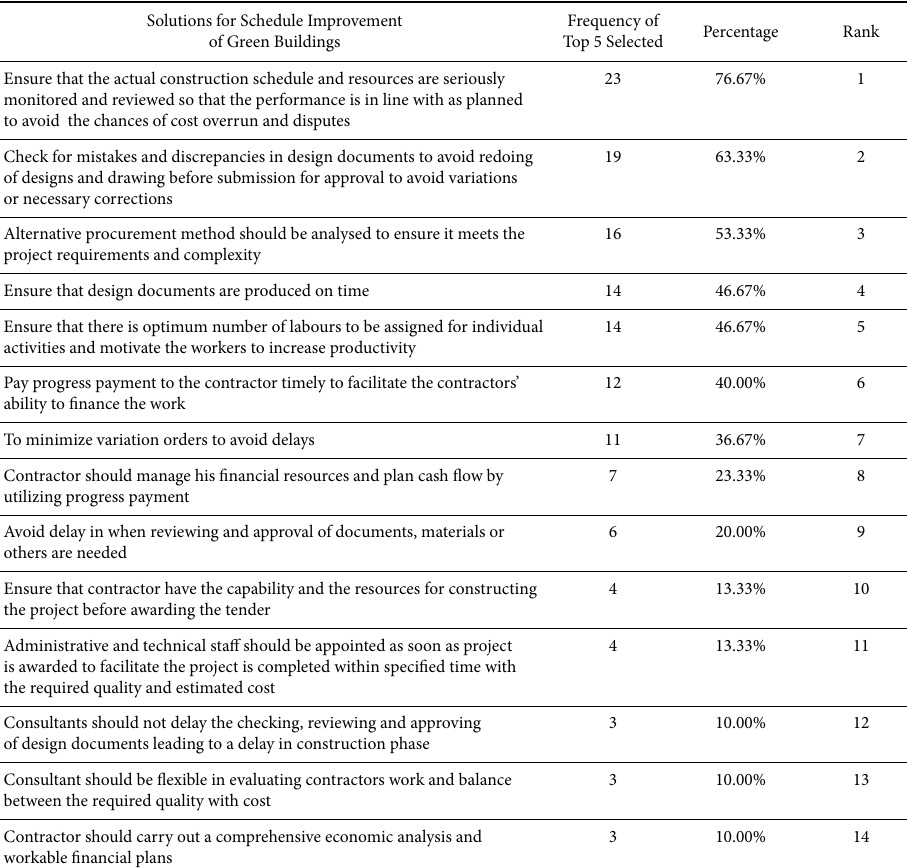
Table 5. Solutions for improving green building project schedule performance Solutions for Schedule Improvement of Green